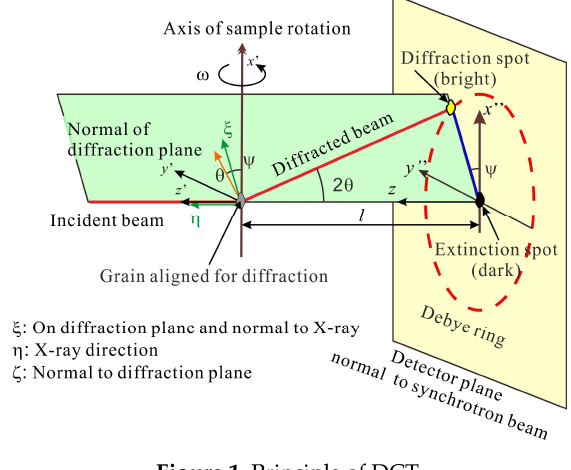
Figure 1. Principle of